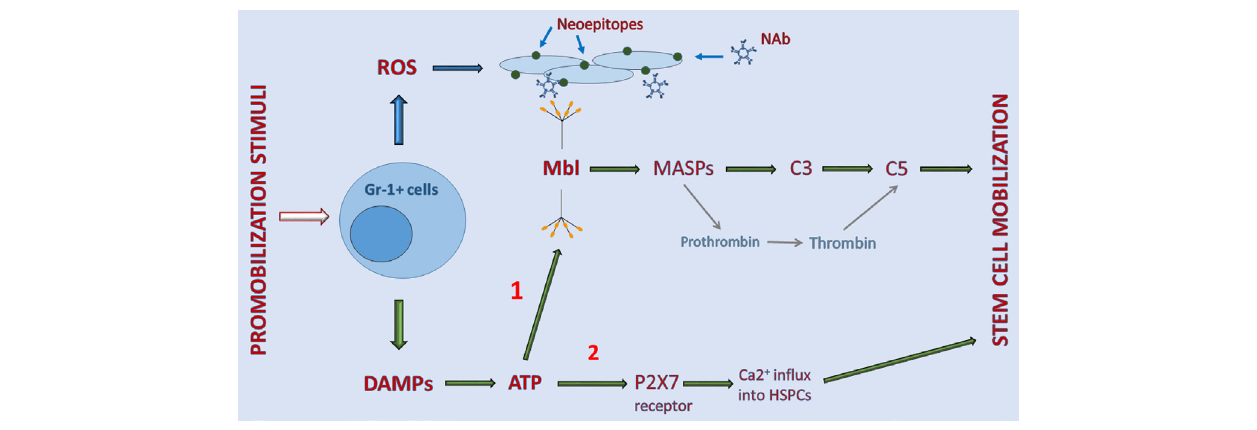
FiGURe 1 | Interaction between elements of purinergic signaling and activation of the complement cascade (ComC) in the induction of sterile inflammation in bone marrow (BM). Stimulatory factors released during tissue/organ injury, systemic mediators of inflammation, and pharmacological inducers of hematopoietic stem/progenitor cells (HSPC) mobilization activate Gr-1 + leukocytes in BM to release danger-associated molecular patterns (DAMP) molecules, including adenosine triphosphate (ATP) and reactive oxygen species (ROS). As a DAMP molecule, ATP is recognized by MBL, which activates the ComC and CoaC in an MASP-dependent manner ( indicated on a graph as 1 ). By contrast, ROS exposes neoepitopes, and neoepitope–IgM complexes are also recognized by mannan-binding lectin (MBL). This leads to activation of the ComC by the MBL-dependent pathway. Both classical C5 convertase, as a product of C3 cleavage, and C5-like convertase activity, provided by thrombin cleaving C5 to release cleavage fragments C5a and desArg C5a, are crucial in the egress of HSPCs from BM. In addition to serving as a DAMP ( indicated on a graph as 2 ), ATP also activates purinergic receptors expressed on the surface of HSPCs, in which P2X7 plays an important role in promoting calcium influx into cells ( indicated on a graph as 2 ). This facilitates intracellular actin fiber rearrangement that is crucial in cell migration and egress from BM.